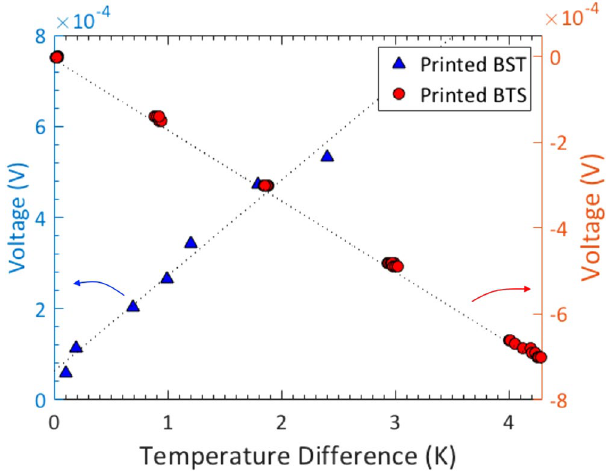
Figure 3. Plots of voltages as a function of temperature difference to obtain the Seebeck coefficient from the slops with p-type BST and n-type